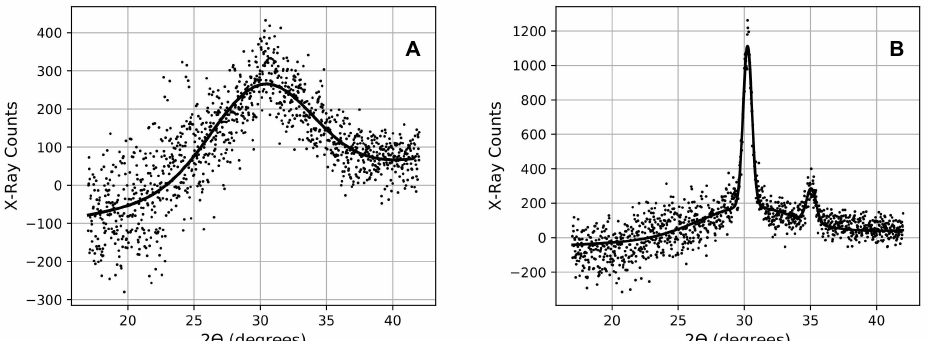
Figure 2. For each X-ray Diffraction (XRD) scan, the coating film contribution was obtained as the subtraction of the uncoated backside from the profile. On graph ( A ), only the amorphous component was visible while on graph ( B ), it reduced the surface to the benefit of narrower peaks, thus revealing the crystallization. An overall slope, due to the deposited coating slowly changing the X-ray attenuation, was accounted for in the fit with a first-degree polynomial in addition to the three Gaussian functions describing the individual